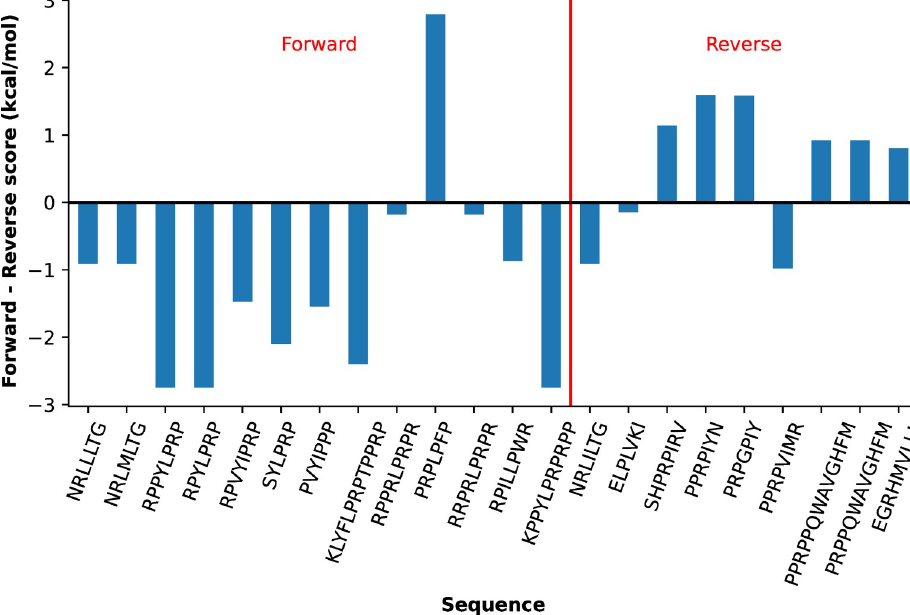
Fig 7. Prediction of substrate binding orientation by Paladin. The difference between the lowest forward and reverse scores will be negative when the for5tward orientation is favored, and vice versa. Substrates that actually bind in the forward orientation are labeled on the left of the red dividing line, and those that actually bind reverse are on the